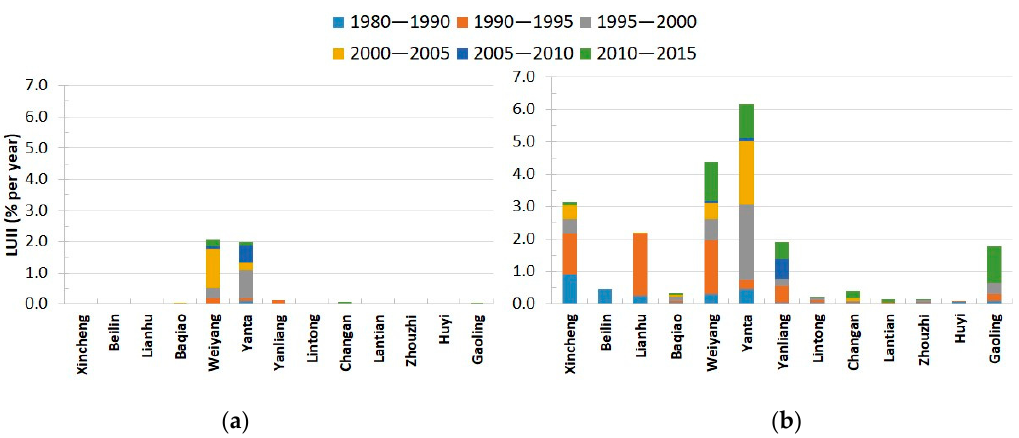
Figure 5. Evolution of the land urbanization intensity index (LUII) over the analyzed period (1980–2015) on the district/county level for two categories: ( a ) conversion from rural built-up to urban built-up area, and ( b ) conversion from farmland to urban built-up area.